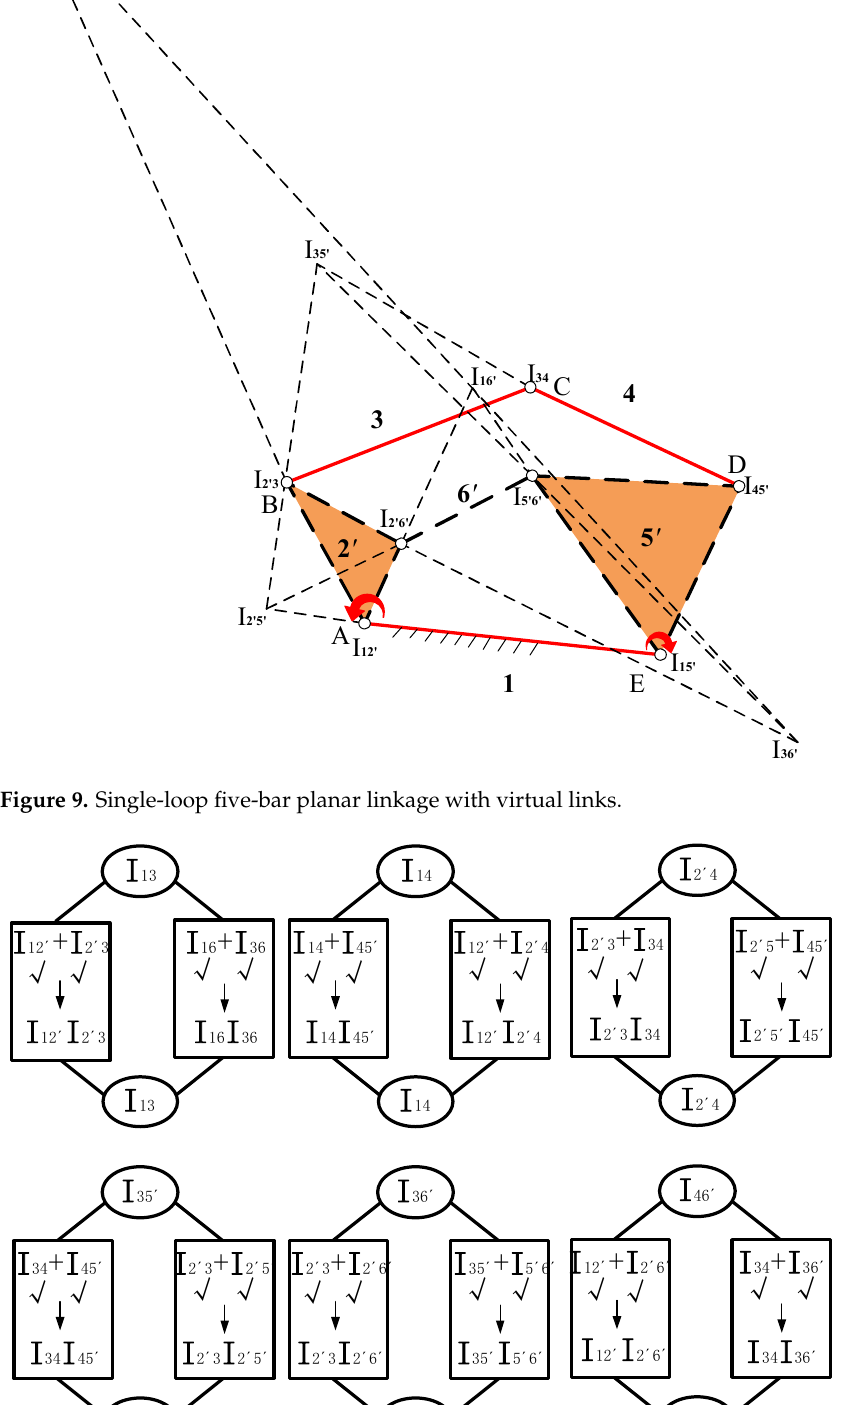
Figure 10. The instant center identification process graph of five-bar planar linkage with virtual links. Table 3. Instant centers of Stephenson linkage with the virtual links.